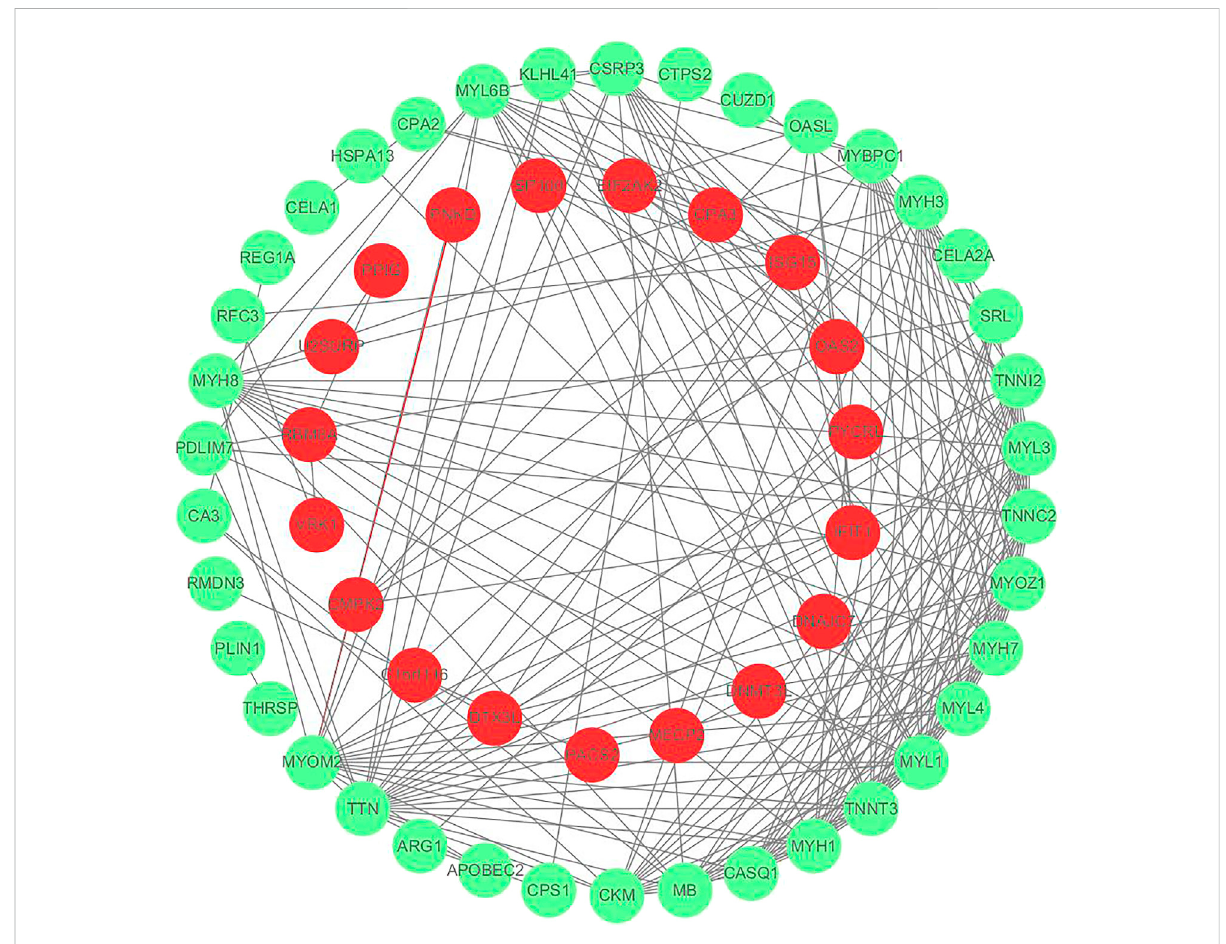
FIGURE 3 Protein interaction network diagram, red represents down-regulated protein and green represents up-regulated